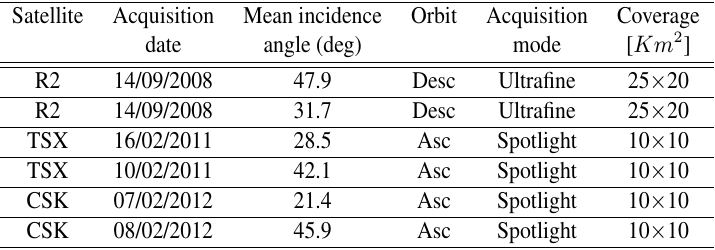
Table 1: Beauport test site images features